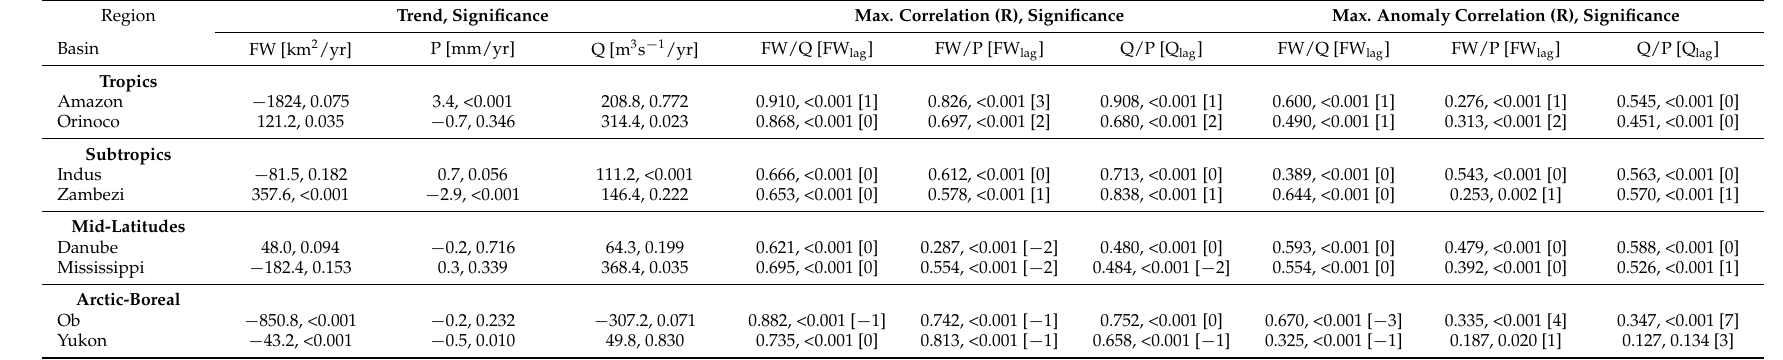
Table 8. Trend analysis from and cross-correlation analysis between monthly mean river discharge (Q) from WBM simulations, basin-averaged total monthly MERRA precipitation (P) and corresponding basin-wide monthly mean total fractional water (FW) extent for eight global river basins over the 13 year, combined v1-QSCAT (2000–2008) and v2-ASCAT (2009–2012) FW record. Shown are annual trends obtained from deseasonalized monthly anomalies (left), the time-lagged cross-correlation (R) at maximum absolute correlation and the corresponding time-lag of the maximum correlation in months for both monthly (middle) and corresponding deseasonalized monthly anomalies (right) as determined from Q, P and FW. Positive time lags indicate that Q, P precede FW or